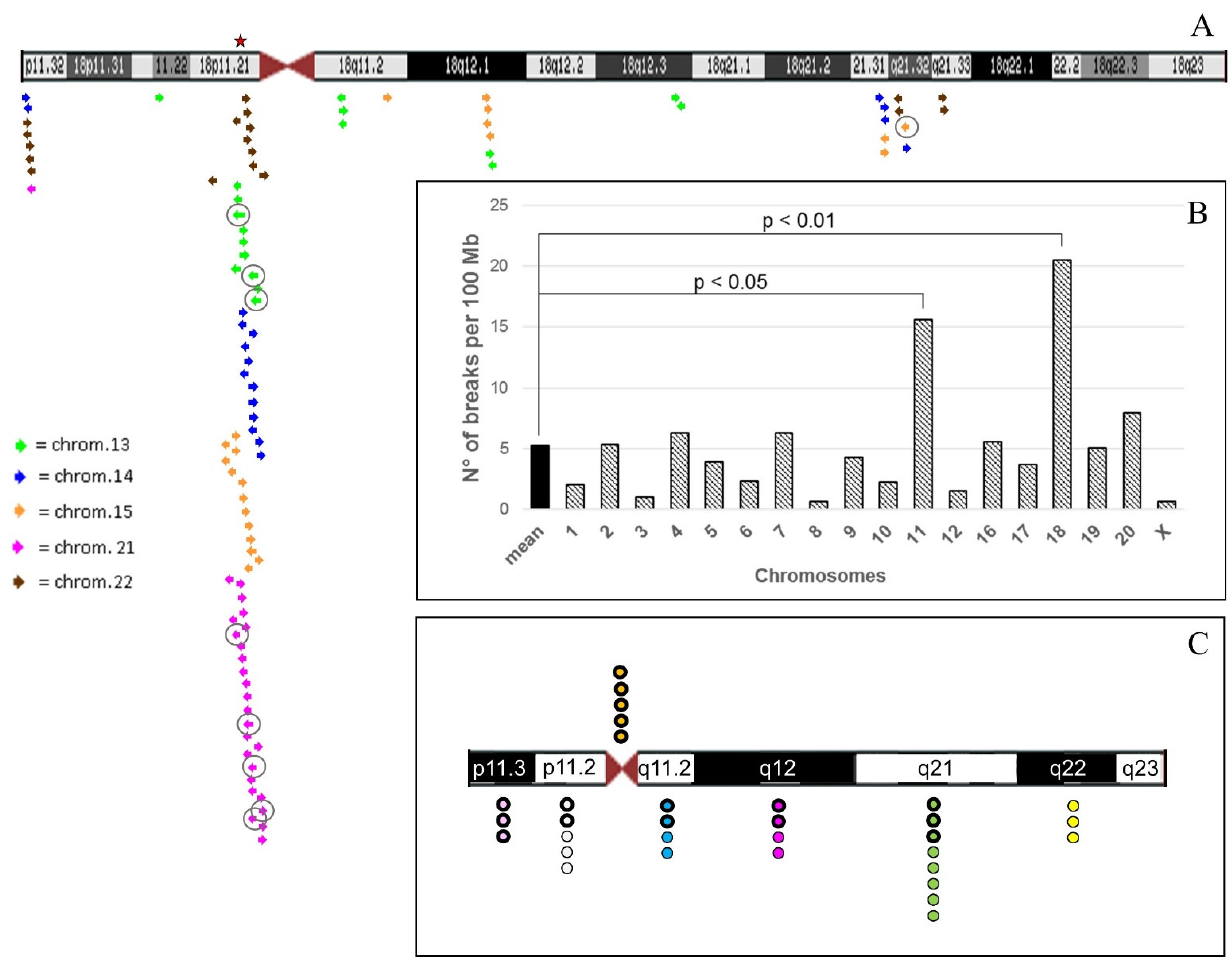
Figure 7. ( A ) Chromosome 18 ideogram modified from UCSC Human Genome Browser—hg19 assembly. The regions of chromosome 18 subjected to analysis are those involved in translocations with acrocentrics. The coloured arrows indicate segmental duplications (duplications of >1000 Bases of Non-RepeatMasked Sequence) with homology 90–98% with acrocentrics, as represented by the inset; the tip of the arrow pointing right indicates the strand +; the tip of the arrow pointing left indicates strand -. The arrows with the circle represent higher homology (98–99%). In particular, 18p11.32 band shows homology with segmental duplications in: 14q11.2, 22q11.1, 22q12.1, 22q13.33 and 21q22.3; 18p11.22 with 13q21.33; 18p11.21 with: 21p11.1-p11.2, 21q11.2, 22q11.1-q11.2, 14q11.1-q11.2, 15q11.2, 13q11.1, 22q13.3, 15q24.3, 14q12, 13q12, and 21q22.3. 18q11.2 with segmental duplications in: 13q14.3 and 15q23; 18q12.1 with 15q22.31, 15q14, 15q26.3, 13q12.11 and 13q14.3; 18q12.3 with 13q12.11; 18q21.31 with 14q23.3, 14q32.2, 14q26 and 15q22.2; 18q21.32 with 22q11.1, 15q23 and 14q31.3; 18q21.33 with 22q12.3. The red star indicates a ~47 Kb sequence with 93% identity between 18p11.21 (BAC RP11-681B3) and 21p11.2 satellite DNA I, II, III (BAC CR381670 [3]). ( B ) Histogram reporting the mean breakpoints number/100 Mb (see Tables S2 and S3). ( C ) 300-band resolution ideogram of chromosome 18 and distribution of breakpoints of translocations listed in Tables 1 and S1. The colors indicate the different cytogenetic bands of chromosome 18 as in Table S1. The thicker edges of the circles show translocations with acrocentrics; the thinnest edges point out translocations with non-acrocentric chromosomes.